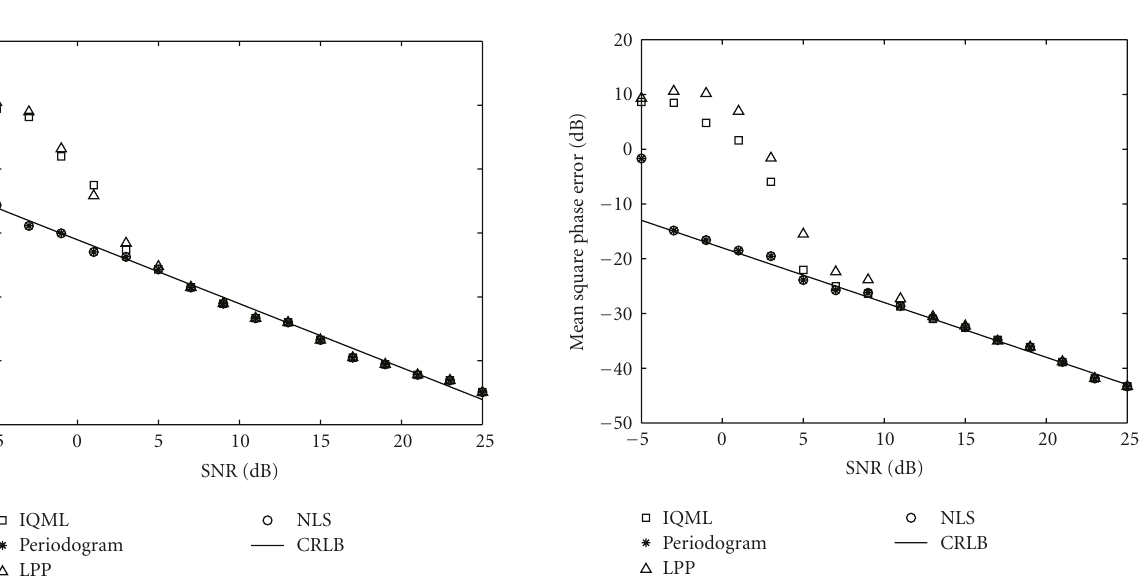
Figure 4: MSE for A of single complex sinusoid at N = 128.